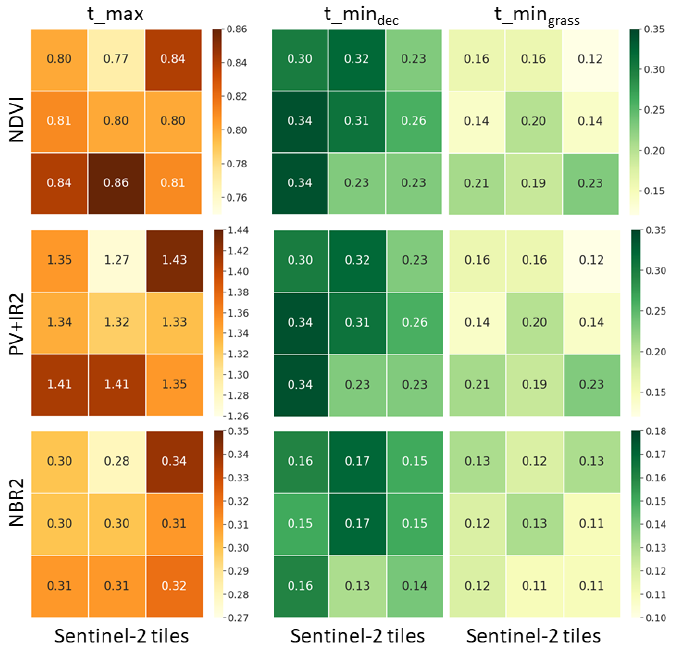
Figure 6. Spatial variability of t _ max and t _ min thresholds across S2